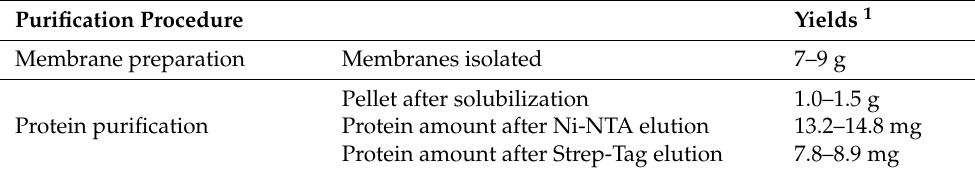
Table 1. Human 4F2hc-LAT1 overexpression and purification